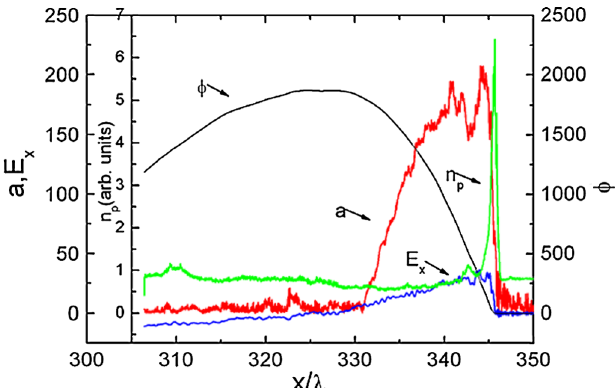
FIG. 3. (Color) The laser amplitude, electrostatic field, electron density, and scalar potential at t ¼ 360 T .